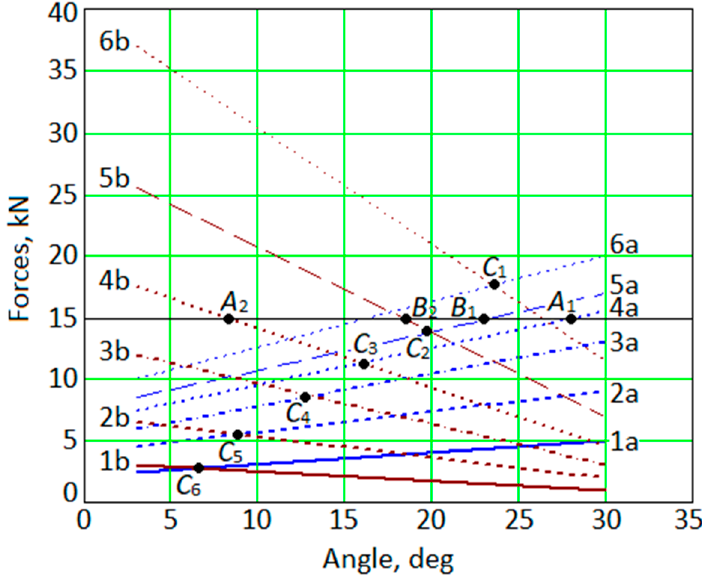
Figure 9. Dependencies of Q k ( α k ) on the angle α [deg] for different displacements Δ [mm]: a— Q 1 ; b— Q 2 ; 1— Δ = 5 mm; 2— Δ = 10 mm; 3— Δ = 15 mm; 4— Δ = 20 mm; 5— Δ = 25 mm; 6— Δ = 30 mm.